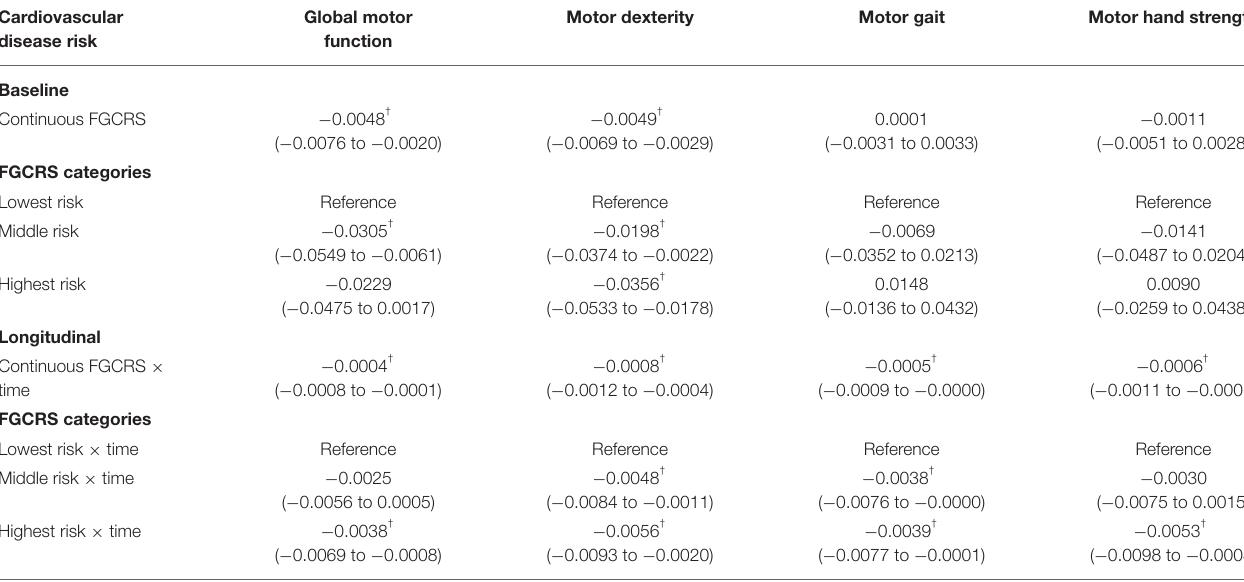
TABLE 2 | β -coefficients and 95% confidence intervals (CIs) for the association of the Framingham General Cardiovascular Risk Score (FGCRS) with the changes of global and specific motor functions over time: results from mixed-effect models *